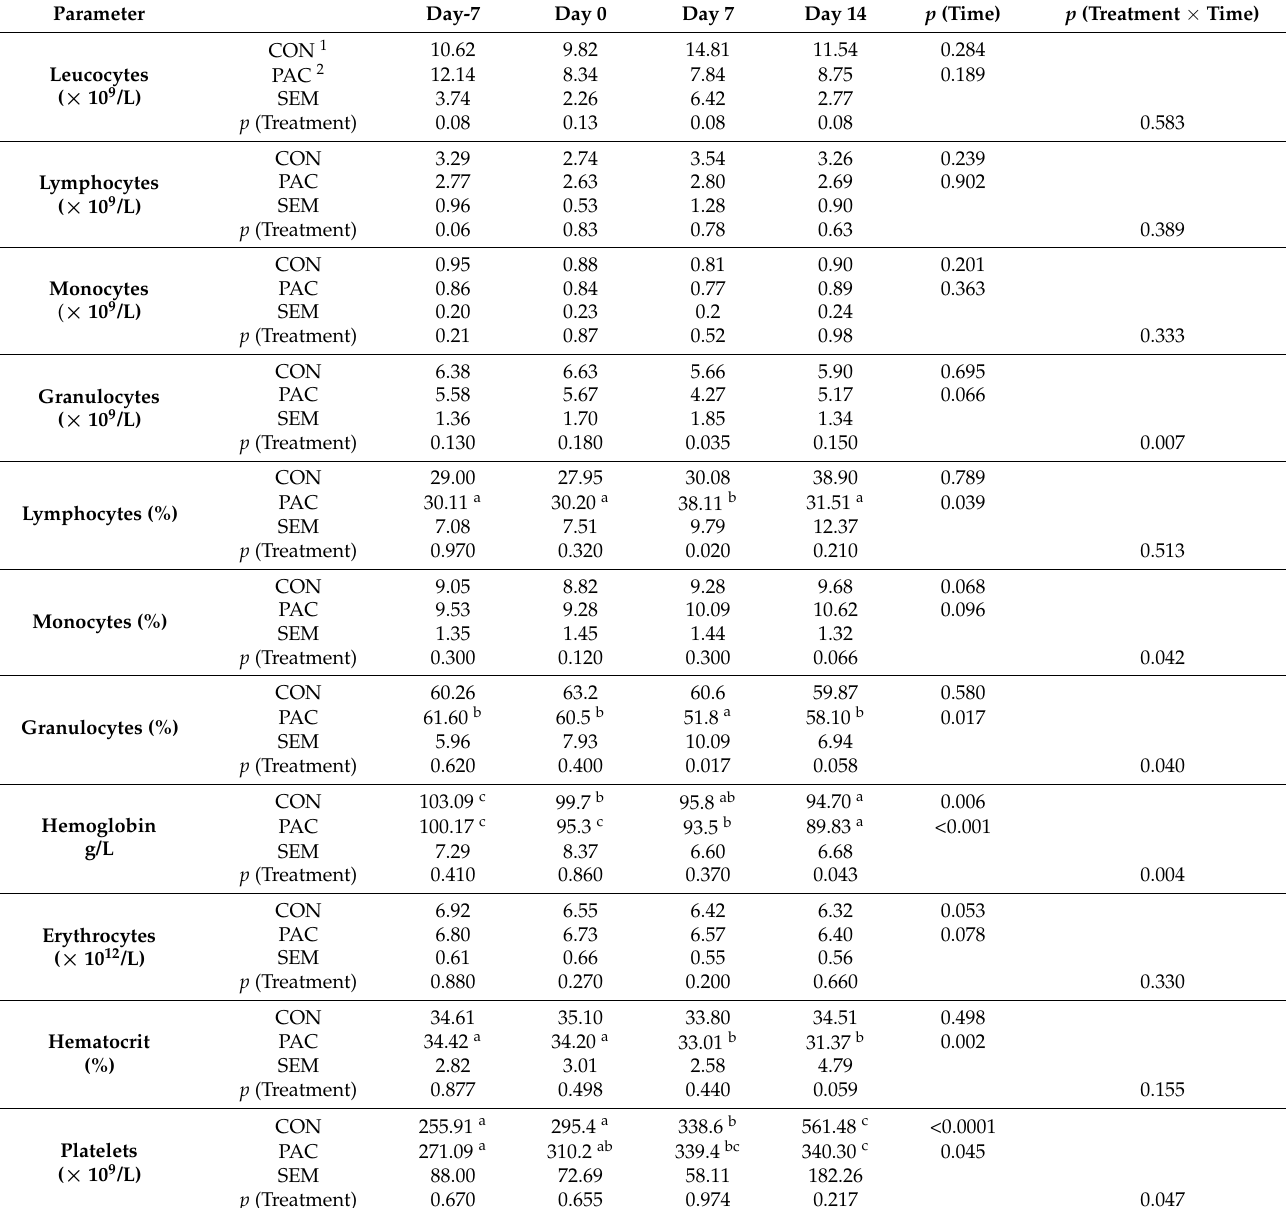
Table 5. Hematological parameters in cows receiving plant bioactive compounds.